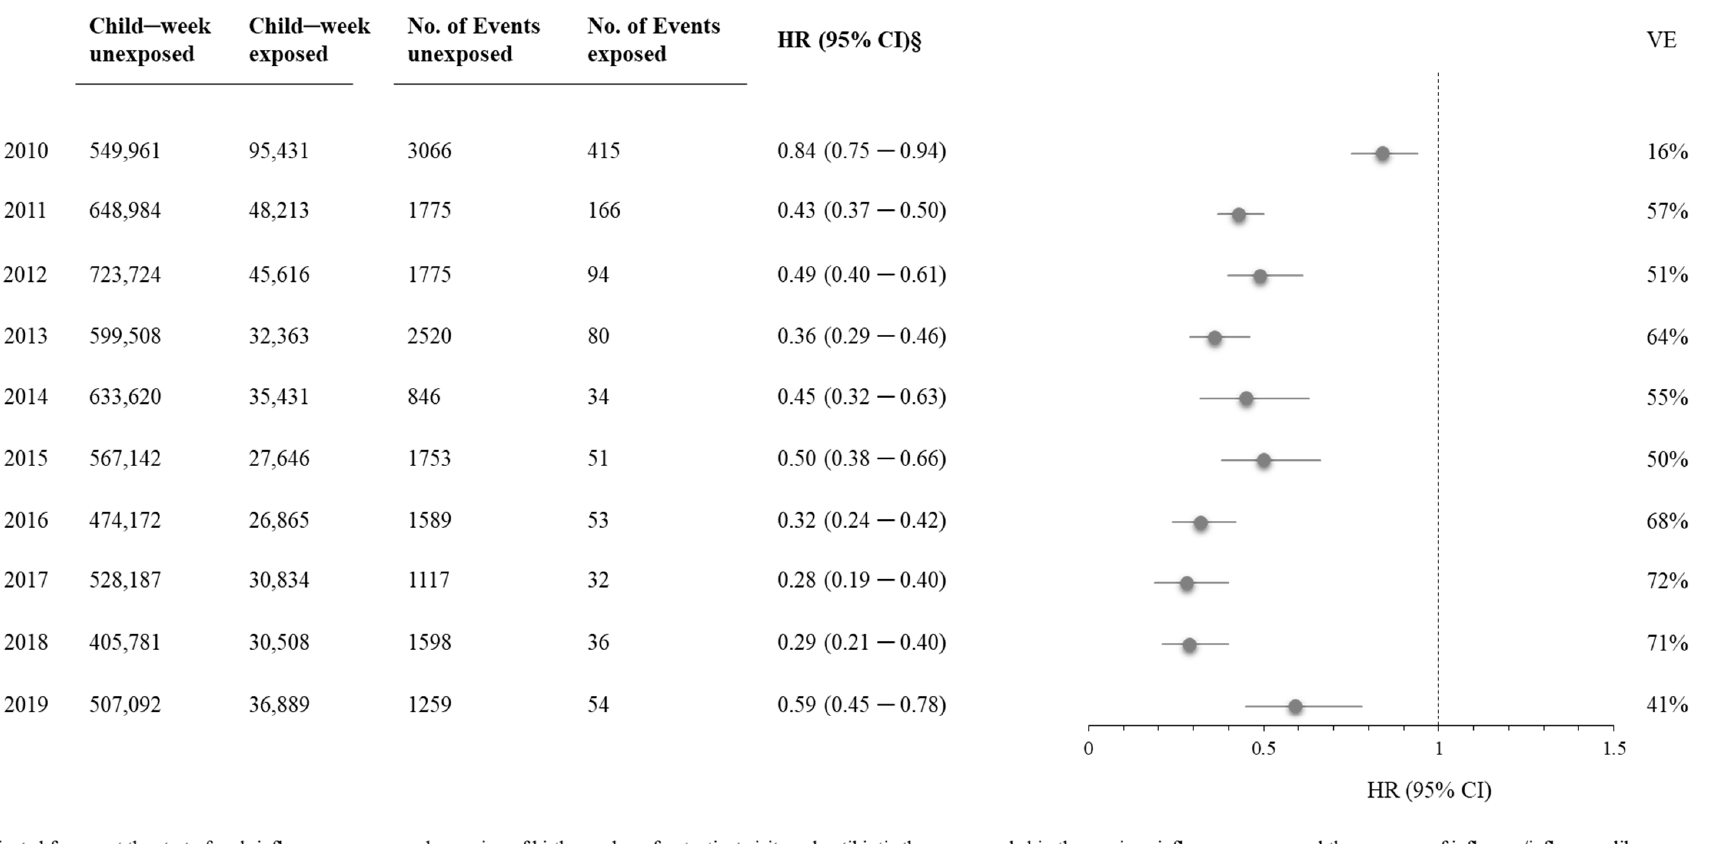
Figure 4. Adjusted hazard ratio and 95% CI for the association between influenza vaccination exposure during each season of interest (from October to April of each year) with influenza and influenza-related complications. Pedianet, 2009–2019.